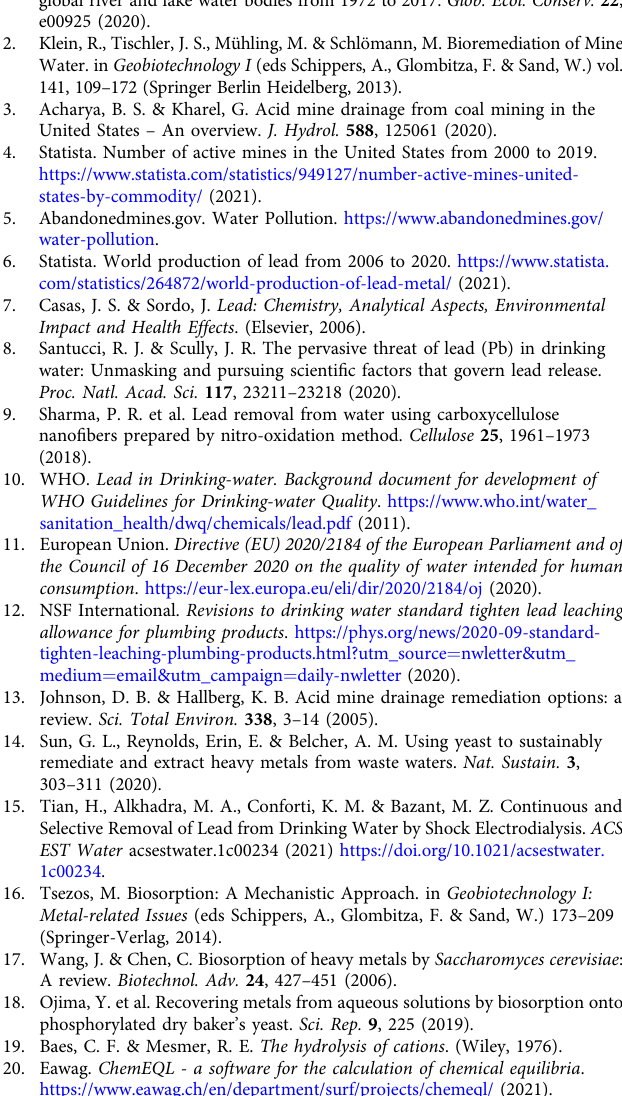
Figure creation . Raw data were collected and stored in CSV or Excel fi le formats. Plots were created using the Origin software.